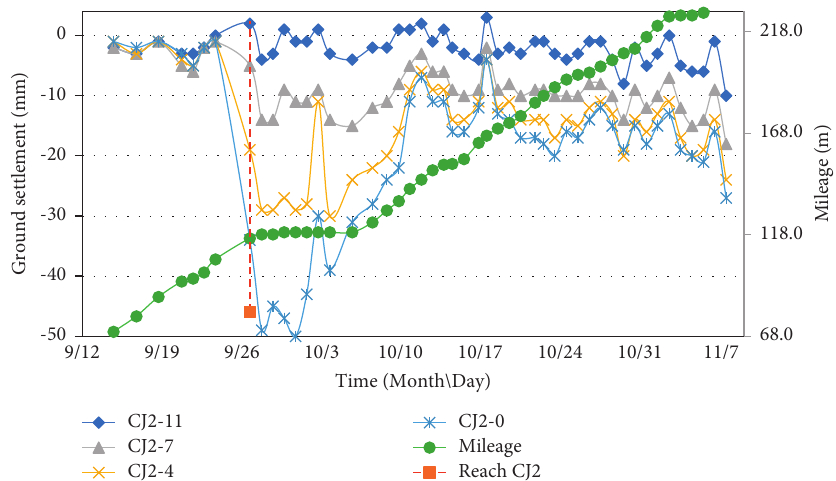
Figure 15: Cumulative settlement of CJ2.